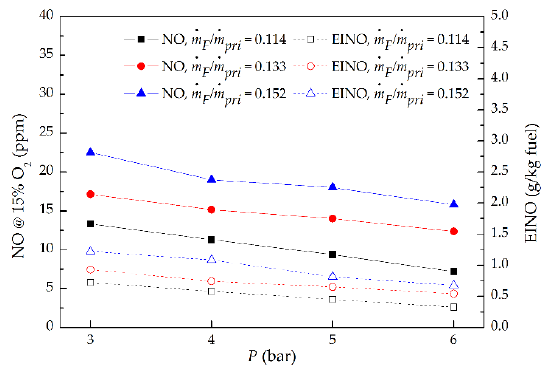
Figure 12. The NO and EINO for combustor pressure under varying ṁ F / ṁ pri ratios.